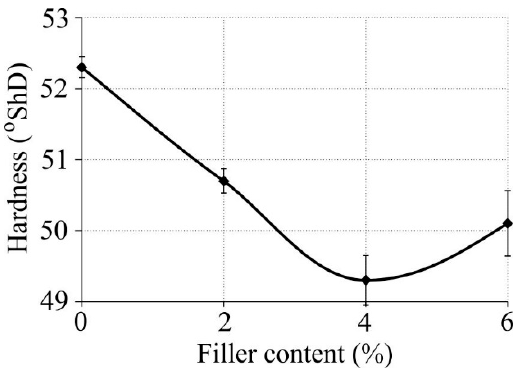
Figure 7. Hardness of produced nanocomposites versus nanofiller mass content.